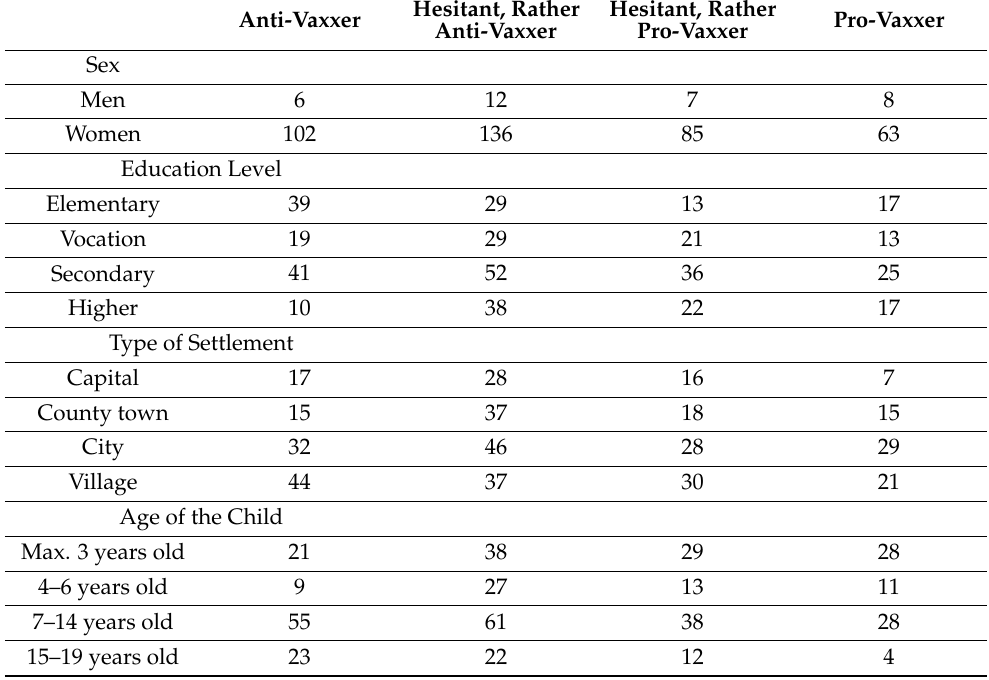
Table A4. Crosstabulation of the general attitudes towards vaccination with different socio- demographic dimensions. Cell